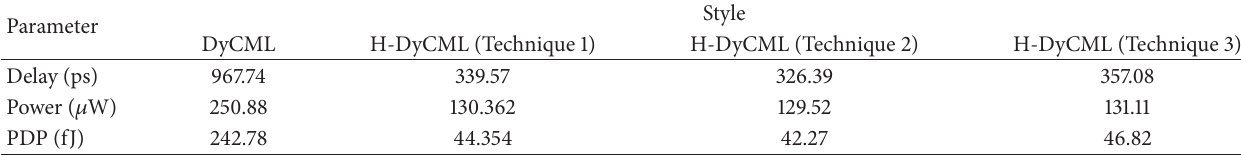
Table 6: Performance comparison of the existing DyCML and the proposed H-DyCML 4-bit